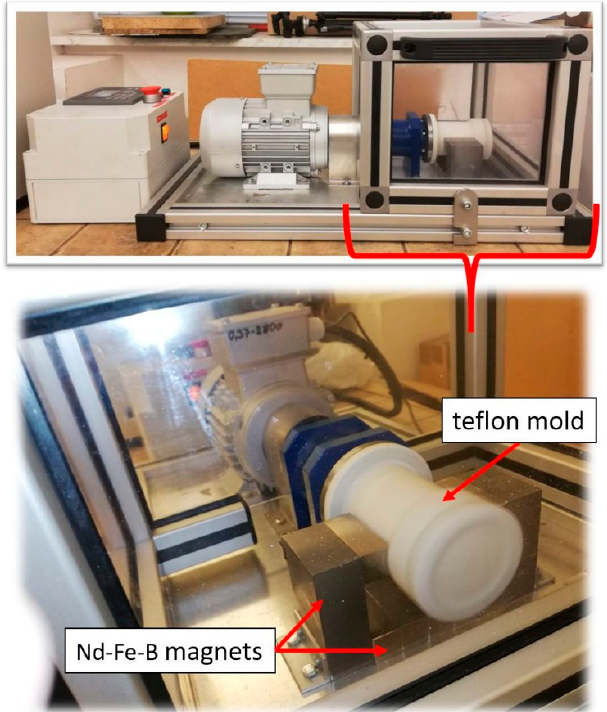
Figure 3. Stand for the production of composites by the method centrifugal slip casting in the magnetic field.